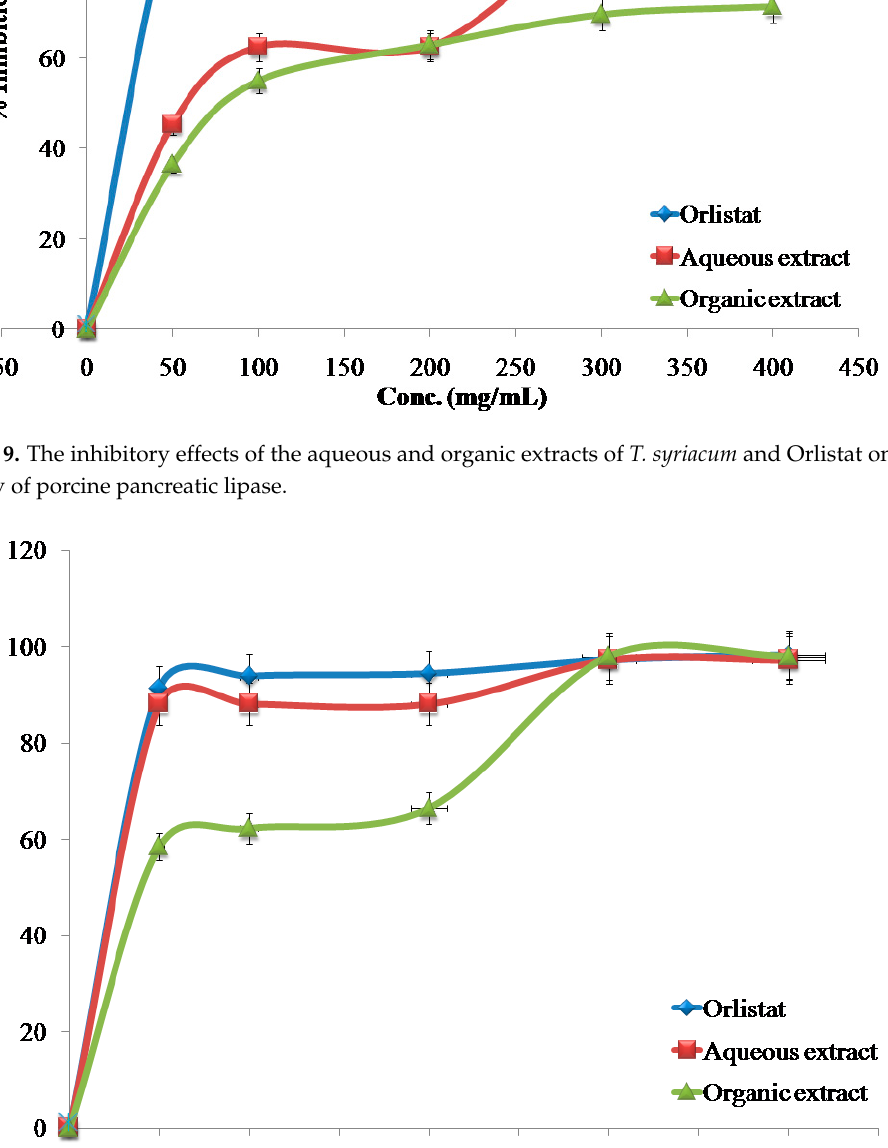
Figure 10. The inhibitory effects of the aqueous and organic extracts of V. vinifera and Orlistat on the activity of porcine pancreatic lipase.